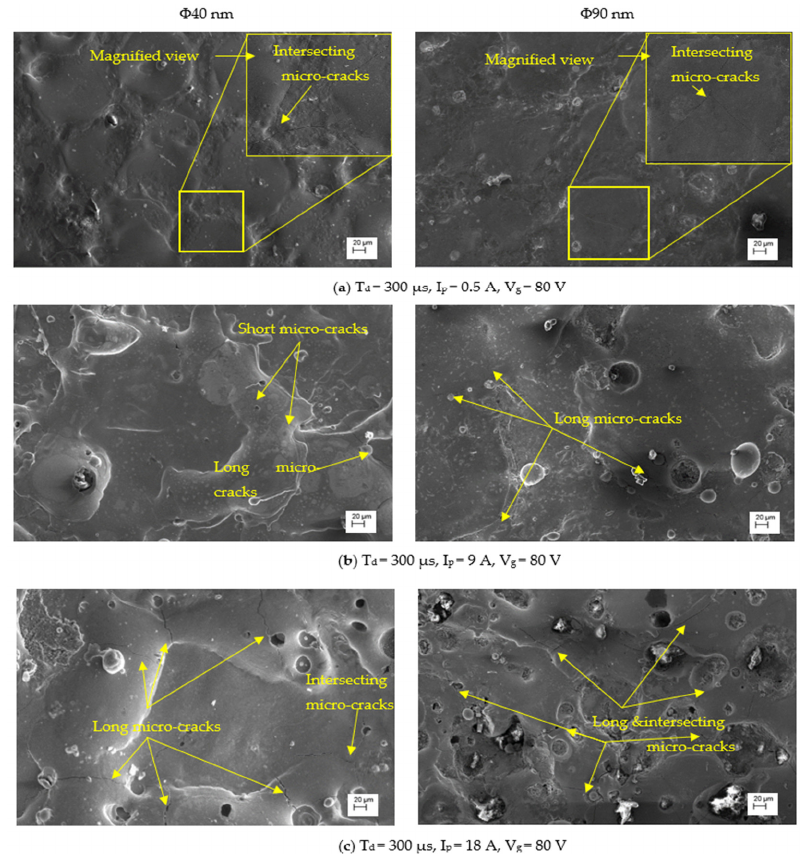
Figure 16. SEM micrographs with variations in peak current.